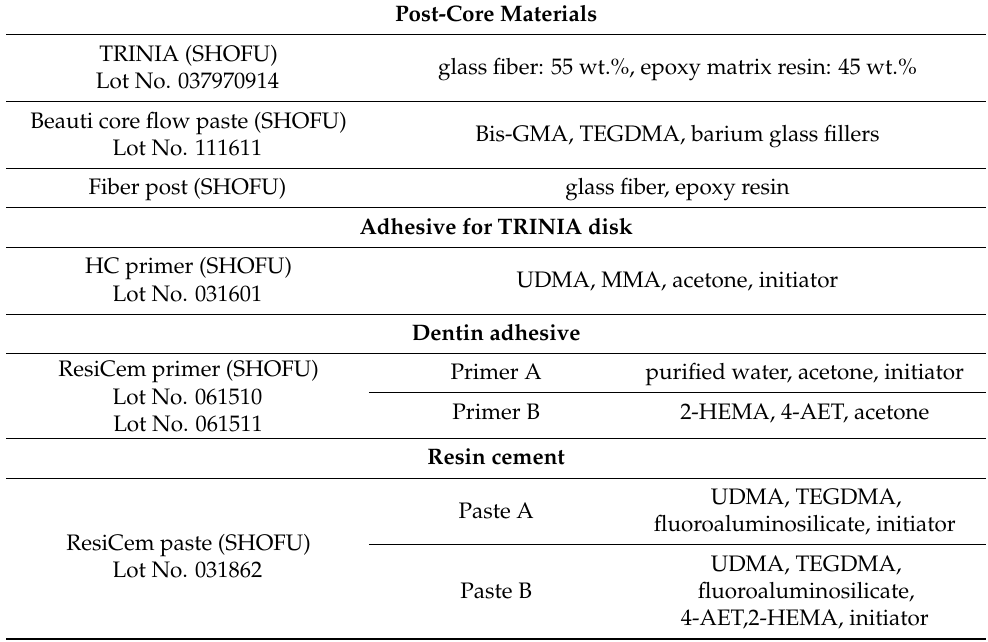
Table 1. Compositions of the experimental